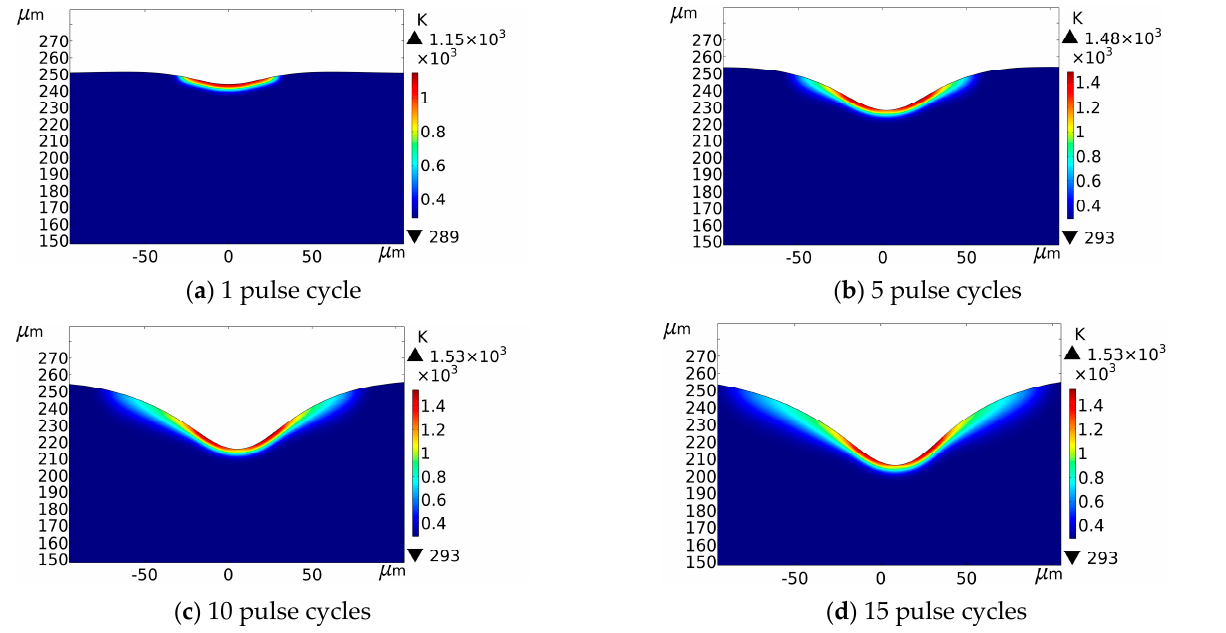
Figure 3. Microstructure morphology and temperature field distribution at different pulse cycles (Average power = 8 W, pulse width = 40 ns, frequency = 150 kHz, scanning speed = 100 mm/s).